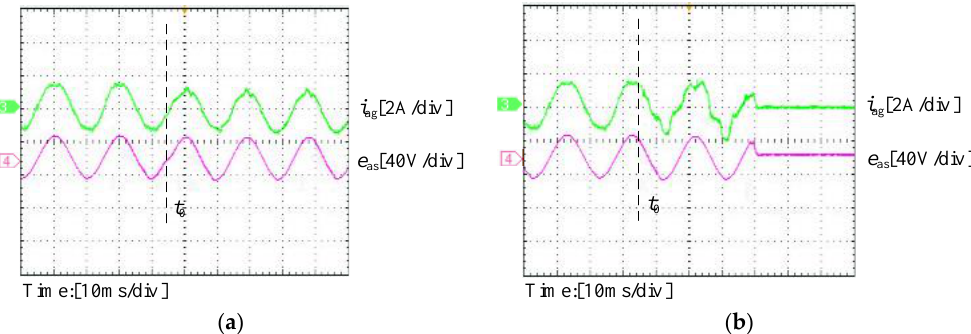
Figure 12. The experimental results with the capacitive load. ( a ) Without the NDZ estimation method. ( b ) With the NDZ estimation method.